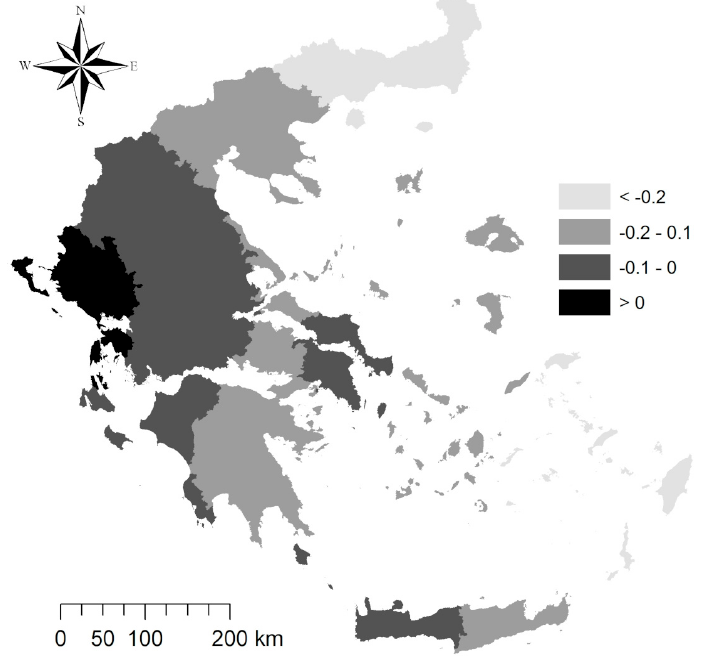
Figure 8. Absolute change in the GWR regression coefficient (local slope) during two consecutive decades in Greece, 1971–1991.